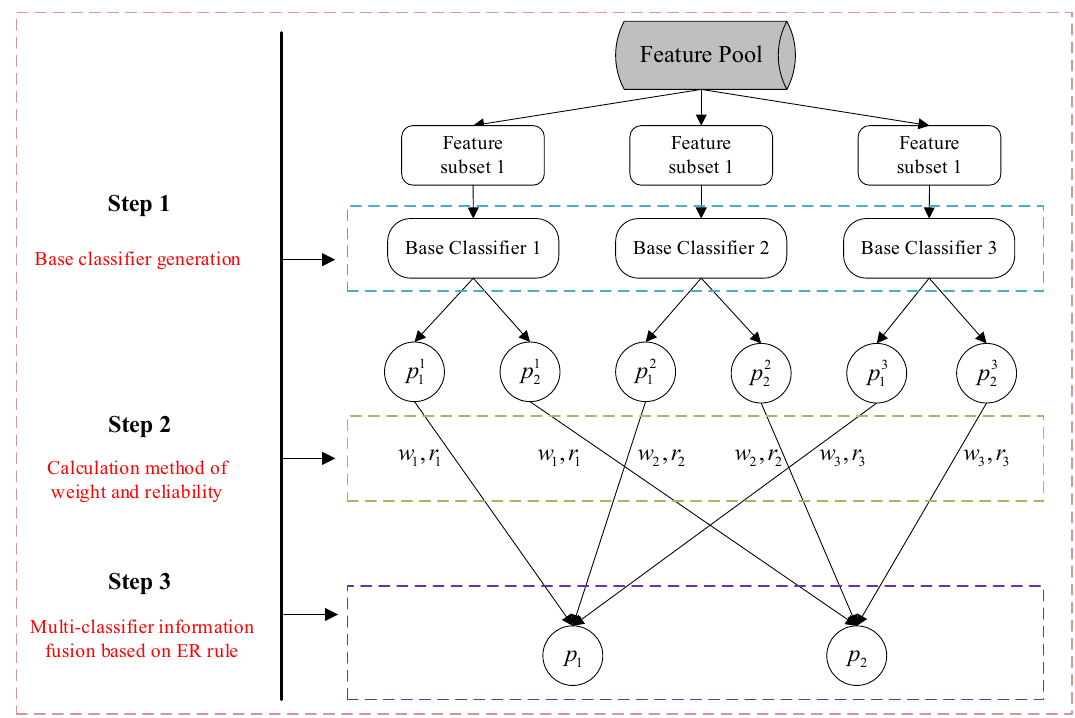
Figure 2. The implementation procedure of the proposed